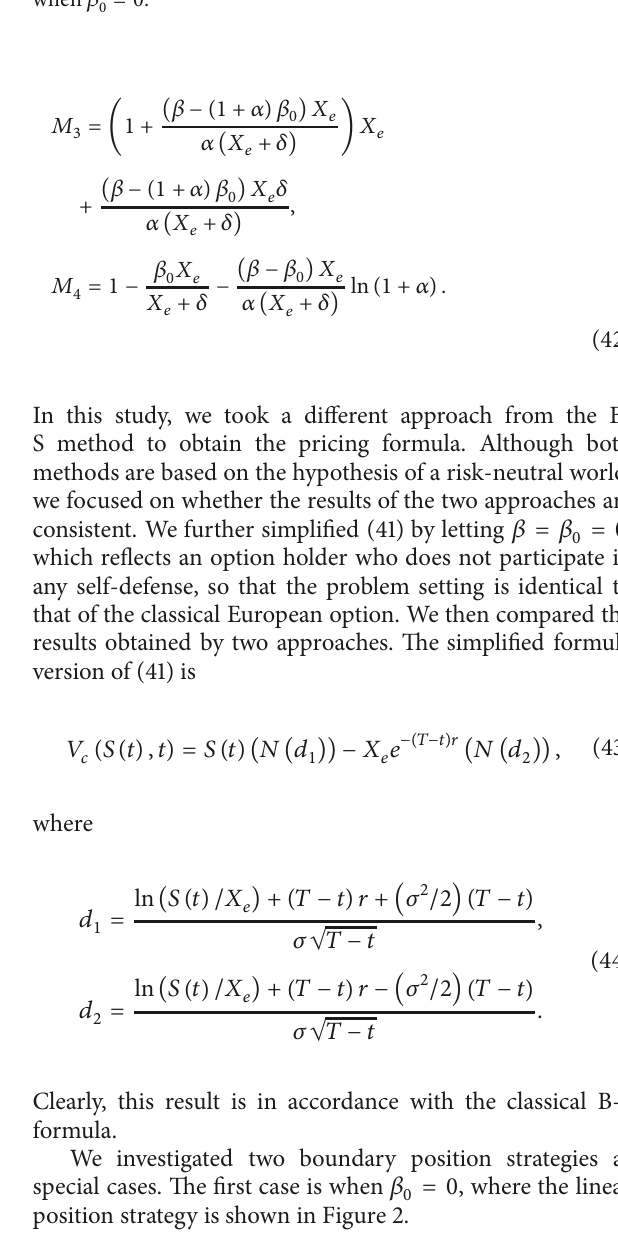
Figure 2: Capital utilization function with linear position strategy when 𝛽 0 = 0